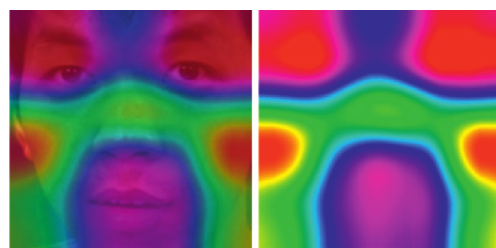
Figure 2: Weights visualization of a layer in a depth neural network for real face texture information extraction. Different face regions occupy different weights in living detection